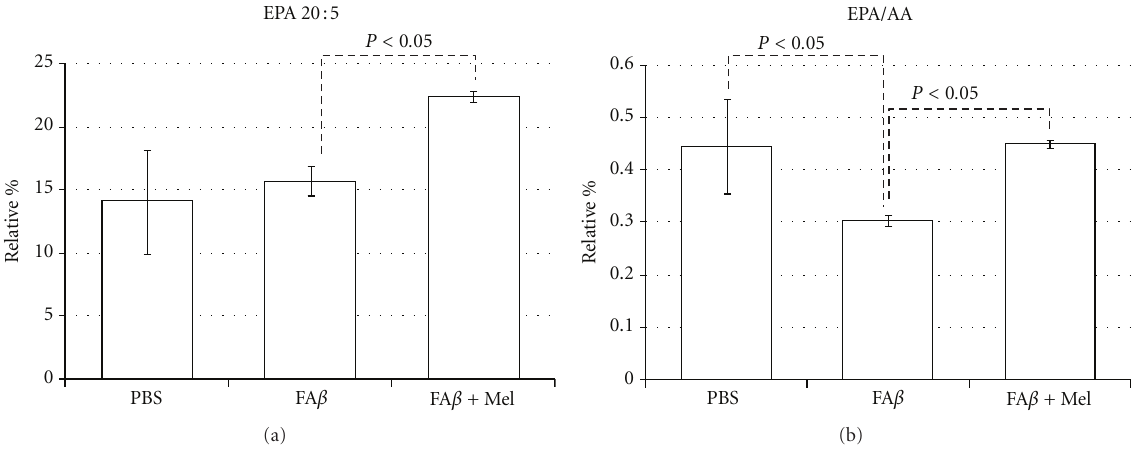
Figure 7: EPA was not to significantly responsive to A β . However, in the presence of melatonin and contrary to the results with the other major n3 PUFA, DHA, the relative percentage of EPA rose significantly, which impacted the EPA/AA ratio, as shown.